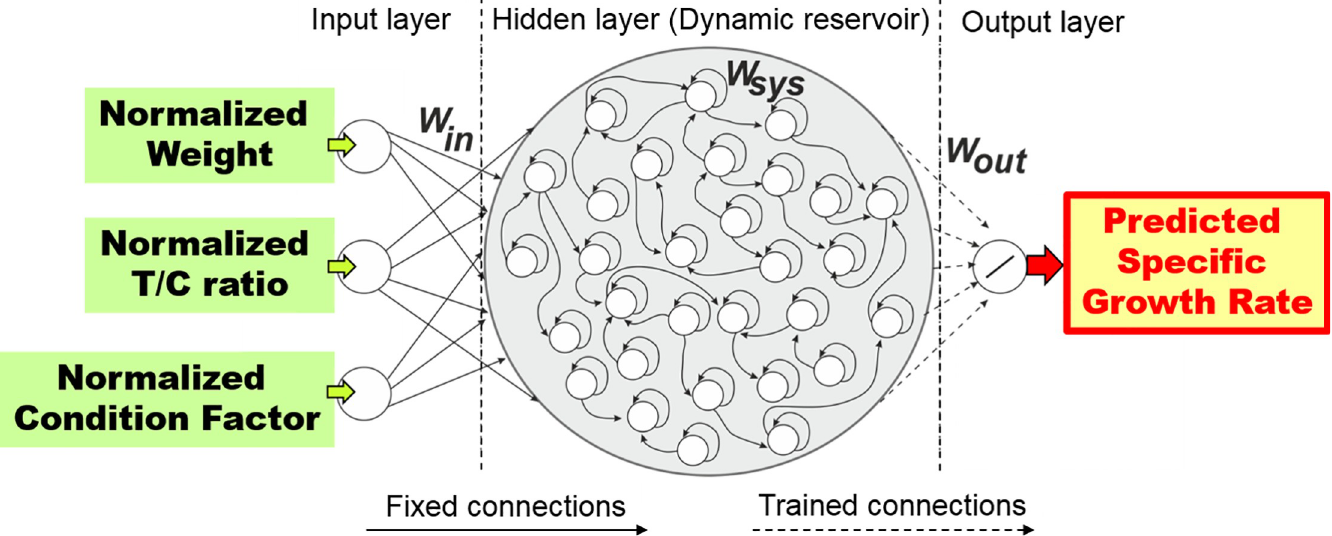
Fig 5. An example of our reservoir-based neural network computational model. In this setup, the input(s) to the reservoir network come from weight, activity ratio of trypsin to chymotrypsin (T/C ratio) in fish pyloric caeca and small intestine, condition factor (CF), or their combinations. The reservoir learns to produce estimated or predicted specific growth rate (SGR)